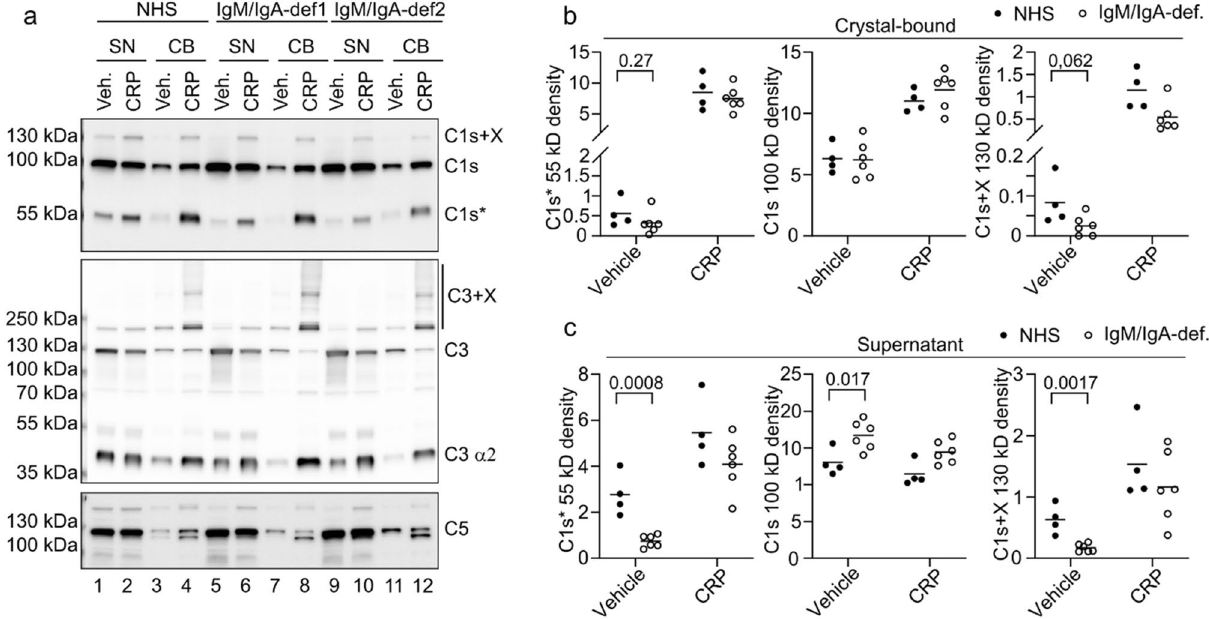
Figure 5. Activation of C1s by IgM and CRP. ( a ) Representative Western blot of supernatants (SN) or eluted crystal-bound (CB) proteins using the indicated antibodies (activated cleavage products are marked with an asterisk*, + X denotes bands that have an apparent molecular weight higher than the full-length protein). Uncropped images and images without enhanced contrast are supplied in the Supplementary Figs. 4 and 5. ( b , c ) Densitometric analysis of Western blots of C1s bands within crystal-bound proteins ( b ) and within the supernatants ( c ) of 4 normal pool sera and 6 IgM/IgA-deficient serum samples incubated with MSU crystals (samples from Fig.